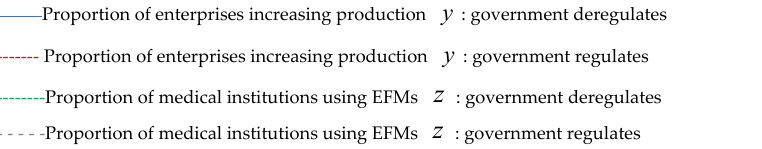
Figure 9. The impact of government regulation on the decisions of hospitals and enterprises.